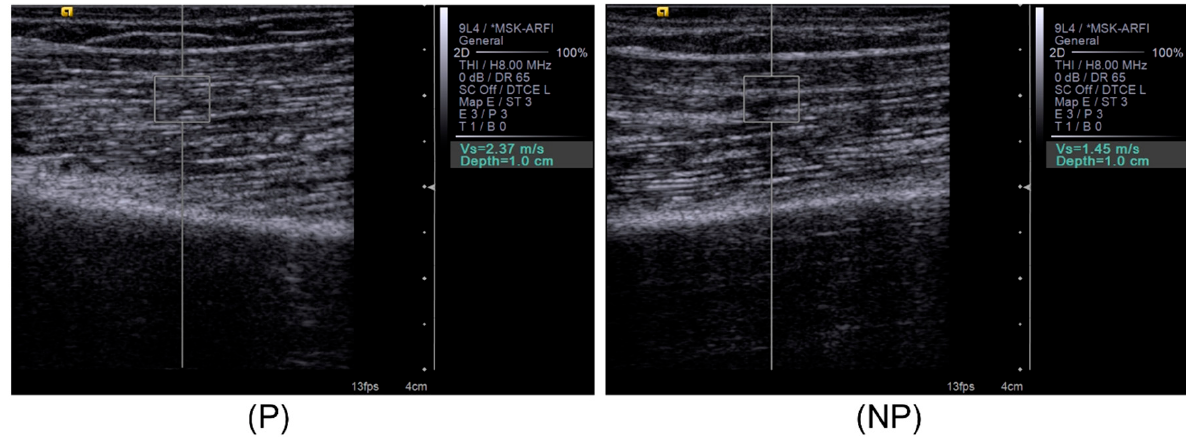
Figure 1. Measurement of shear wave velocity (SWV) in the bilateral biceps brachii muscles (BBM) of a 76-year-old male at 1 month post-hemorrhagic stroke. SWV of paretic (P) BBM (2.37 m/s) was higher than that of non-paretic (NP) BBM (1.45 m/s) in the longitudinal plane.